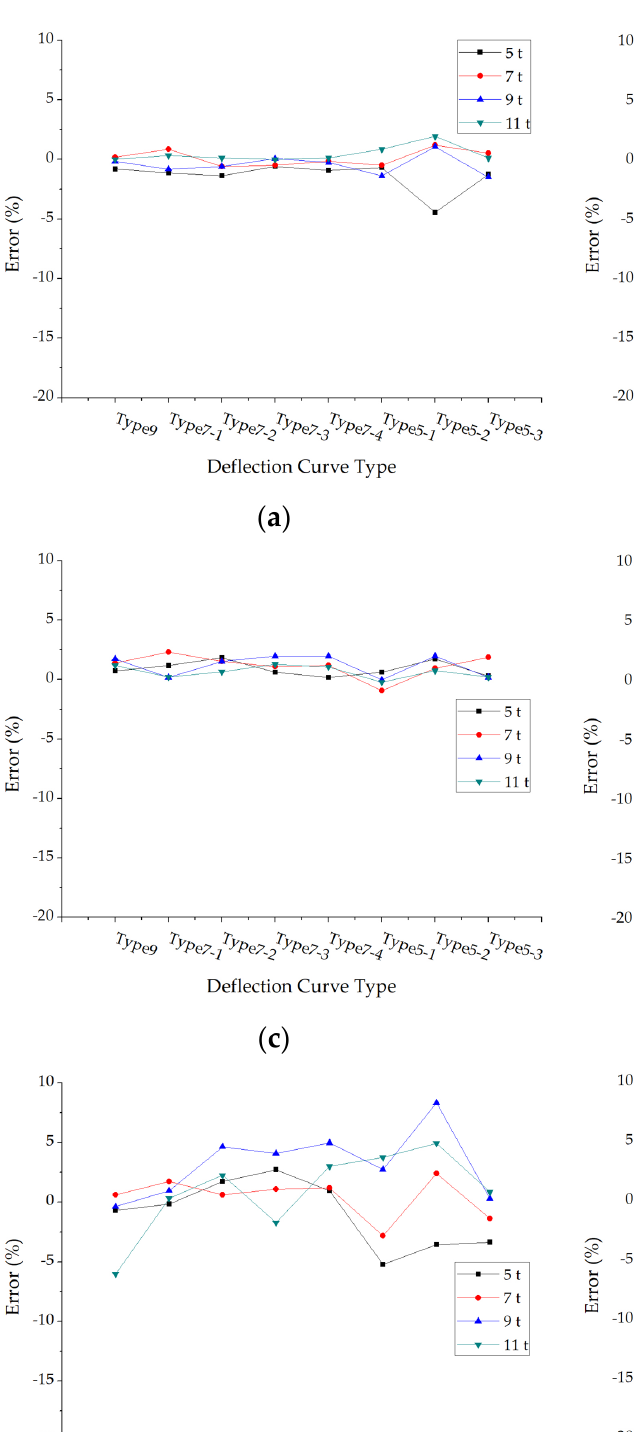
( b ) Figure 6. The average errors of back calculated surface modulus: ( a ) The average errors under dif- ferent deflection curve types; ( b ) The average errors under different axle loads. 3.2.2. Back Calculation Errors of Base Modulus